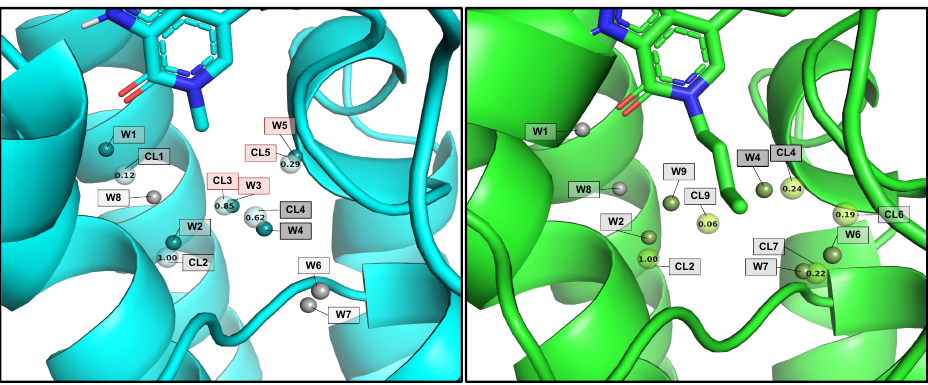
Figure 3. Demonstration of the fragment growing effect in BRD4. In both images, the solid and the transparent spheres are crystallographic and water clusters, respectively. On the left-hand side, we have the results of the aquaPELE simulation. Highlighted we can see W3, CL3 and W5, CL5 almost overlapping. These waters correspond to A319 and A336, respectively, which according to Supplementary Figure S1 are the waters to be displaced upon fragment growth. On the right-hand side, we can see that the water clusters from the frag + aquaPELE simulation disappear, as we show in Table